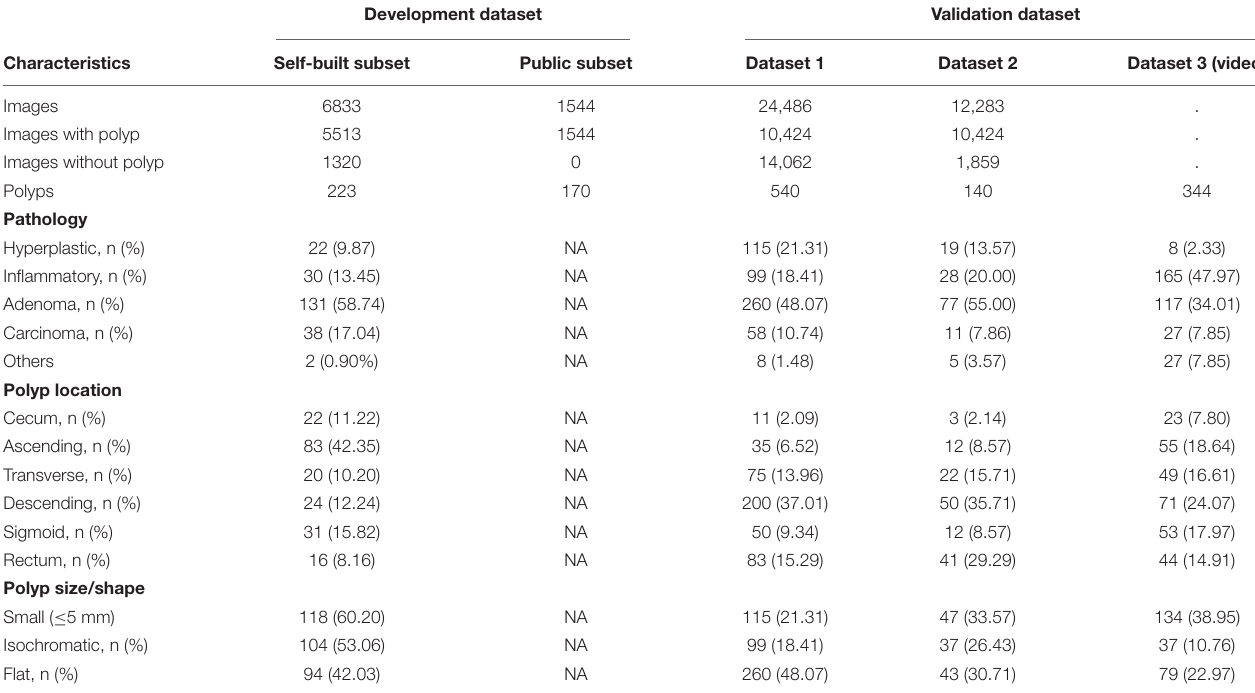
TABLE 1 | Summary of datasets used for model training and validation.